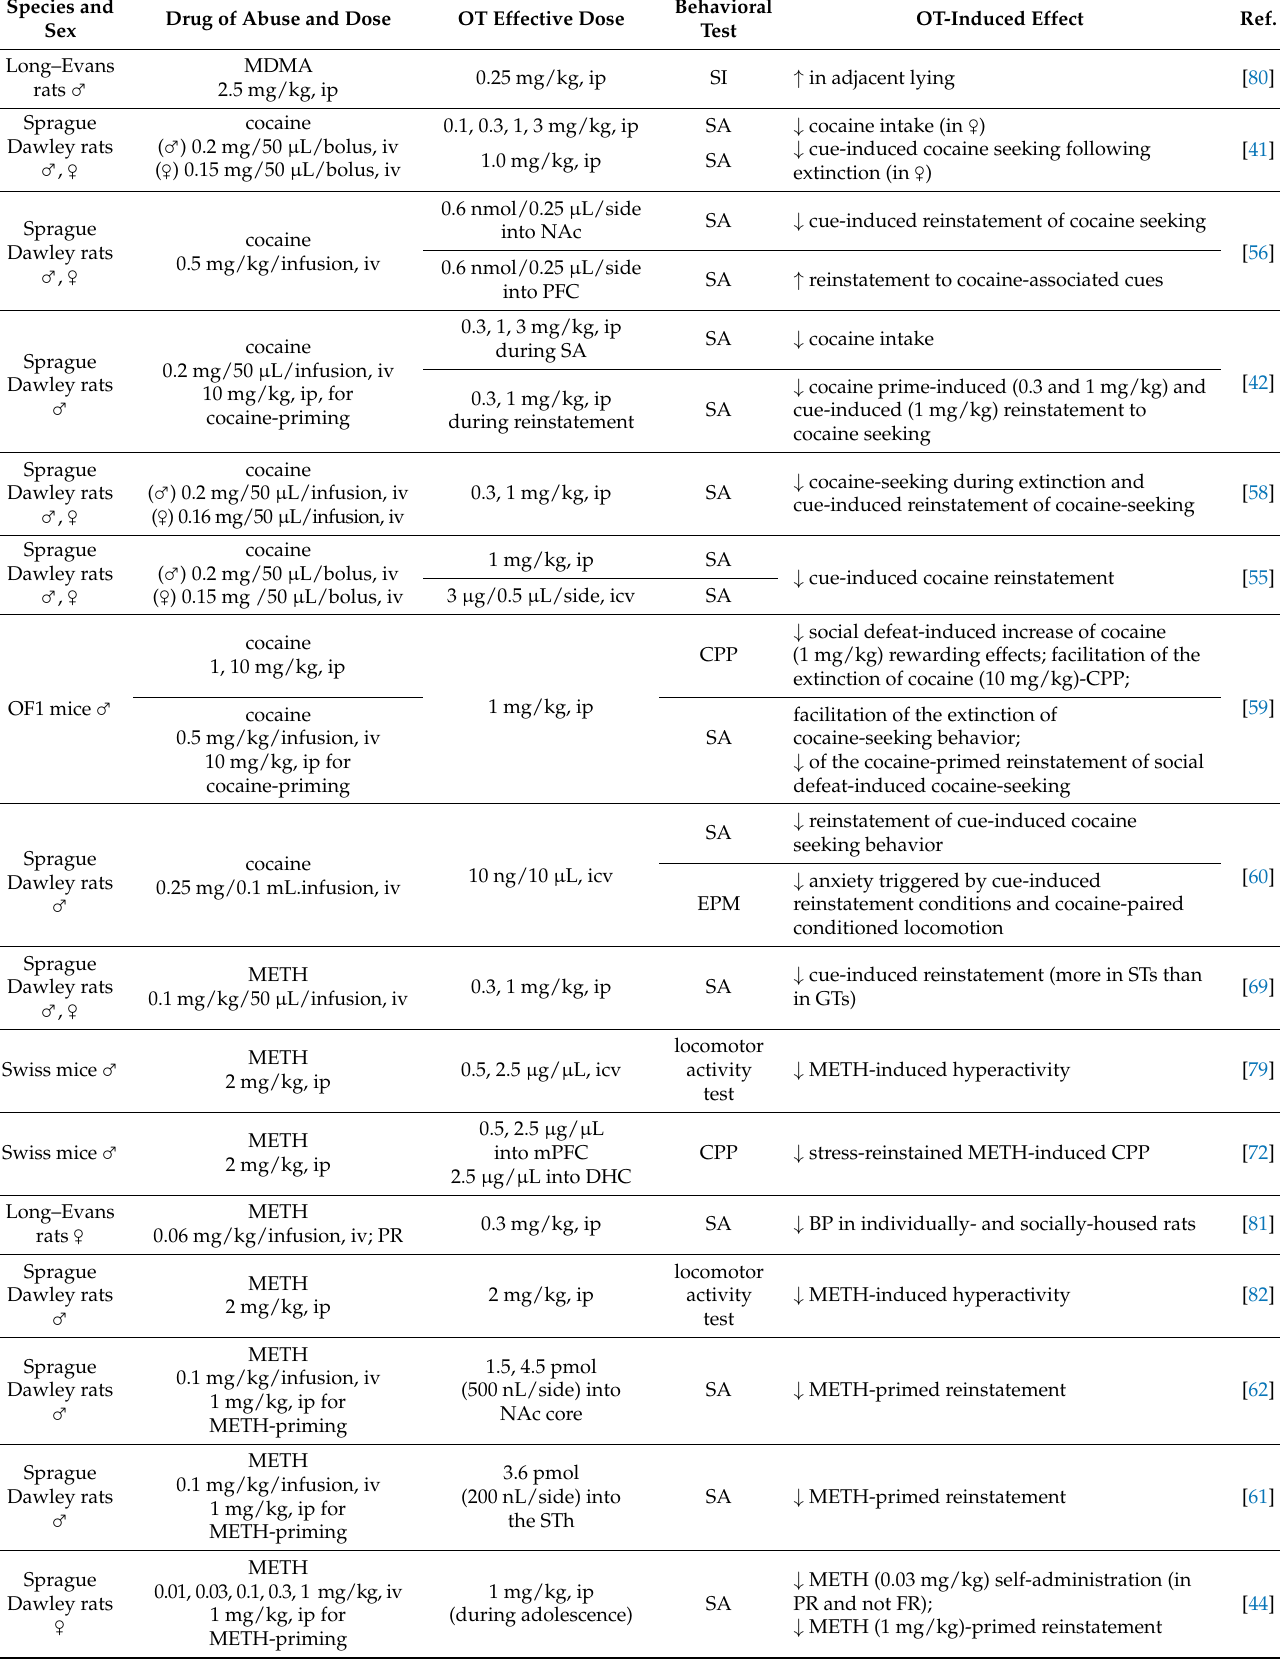
Table 1. The effects of OT on behavioral/rewarding effects of different drugs of